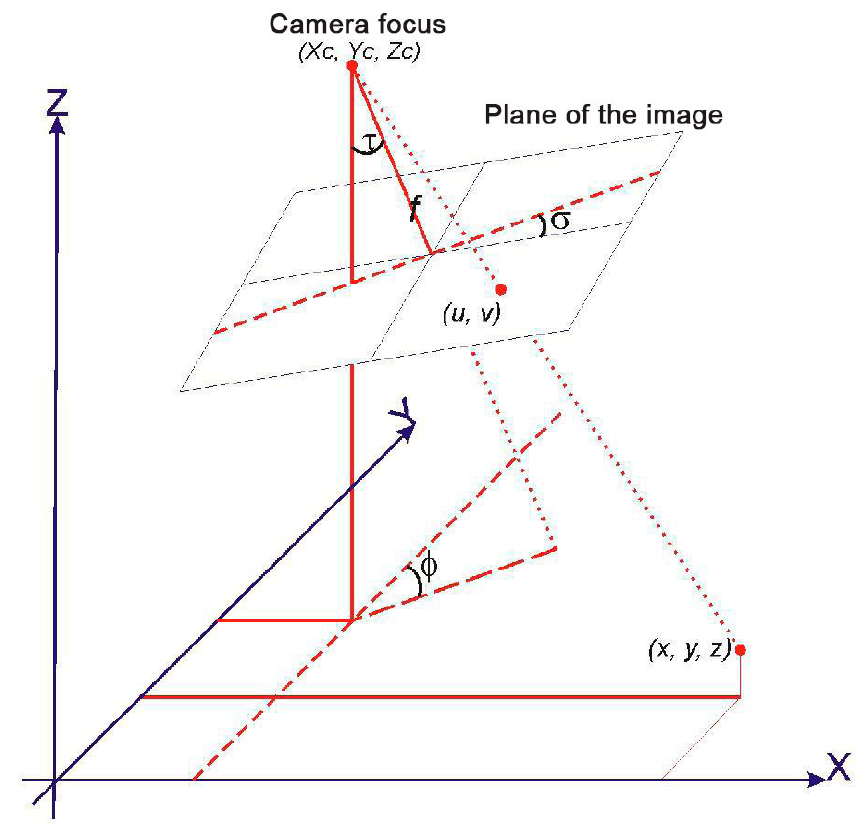
Figure 5. Representation of the collinearity principle for the camera projections.